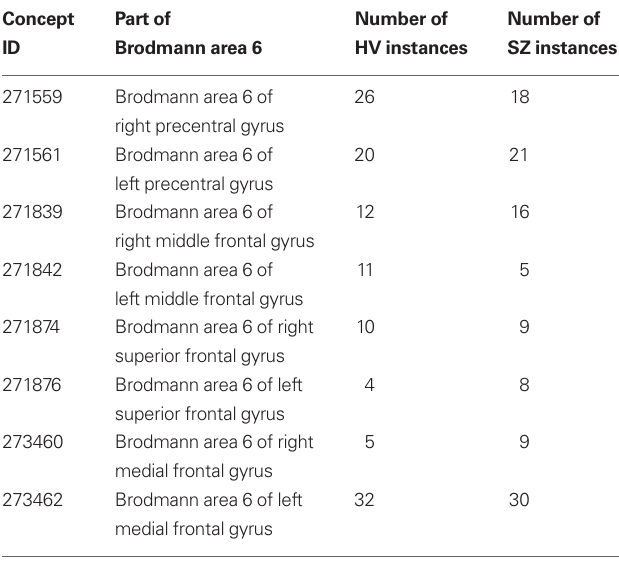
Table 1 | The distribution of activation clusters across different parts